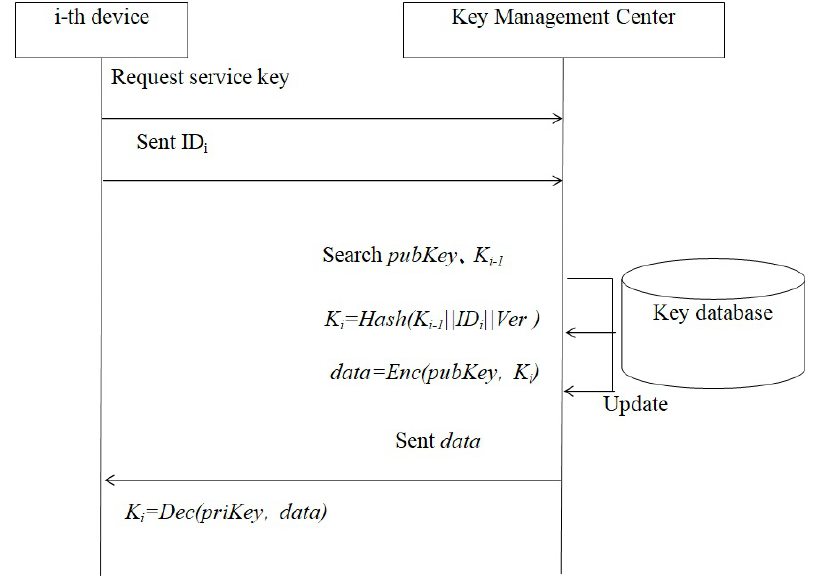
Fig. 4 Key transfer